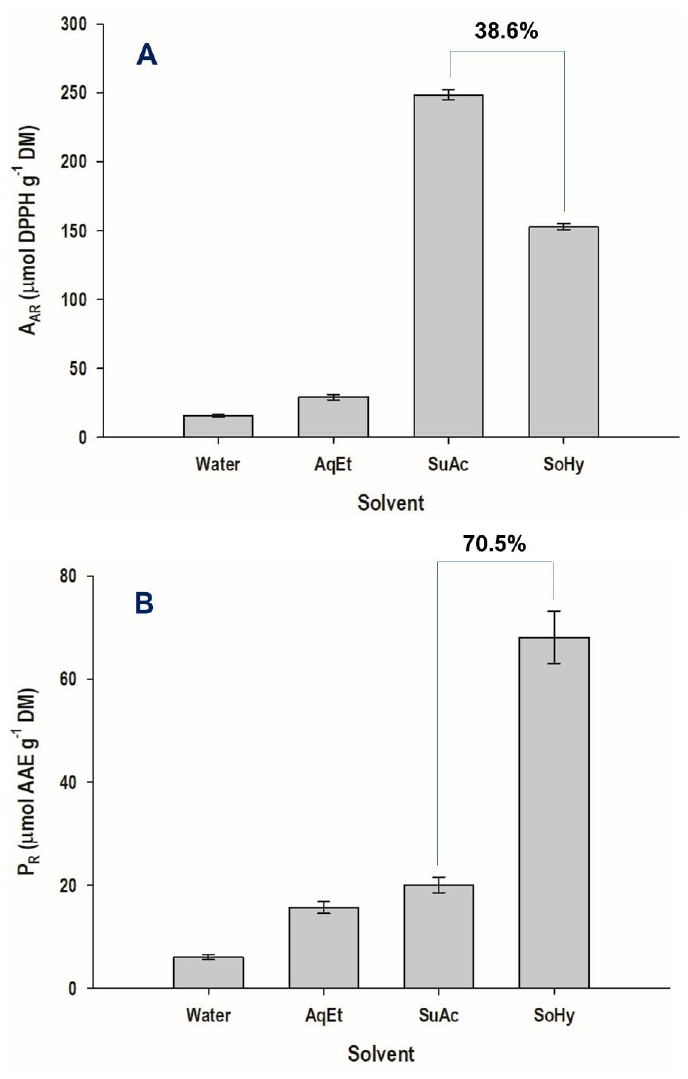
Figure 8. Antiradical activity (A AR ) (A) and ferric-reducing power (P R ) (B) of the extracts produced with sulfuric acid- and sodium hydroxide-catalyzed treatments of wheat bran, under optimized conditions. Water and aqueous ethanol (AqEt) are control treatments. SuAc and SoHy denote treatments catalyzed by sulfuric acid and sodium hydroxide, respectively.